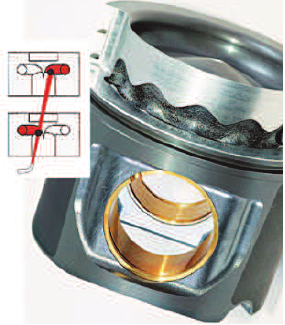
Fig. 14. Oil flow in the dual piston gallery